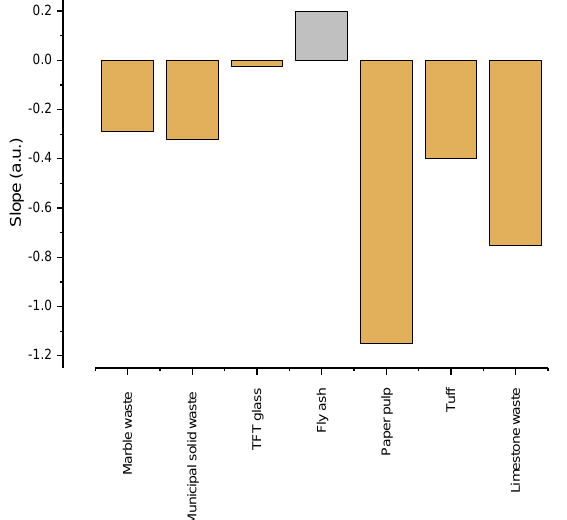
Figure 8. Compressive strength of samples.